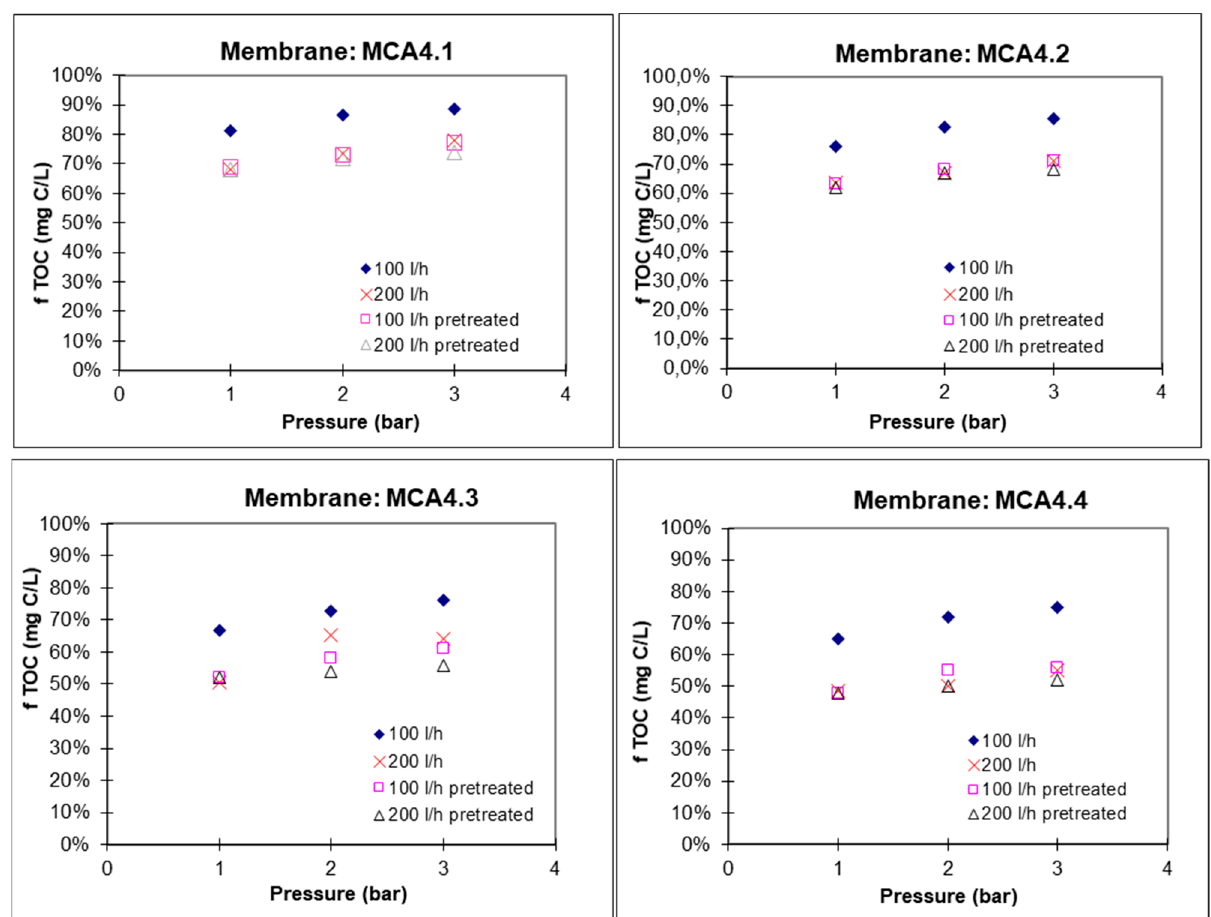
Figure 1. TOC apparent rejection coefficients for varying transmembrane pressures and feed circulating velocities in pretreated and non-pretreated effluents.